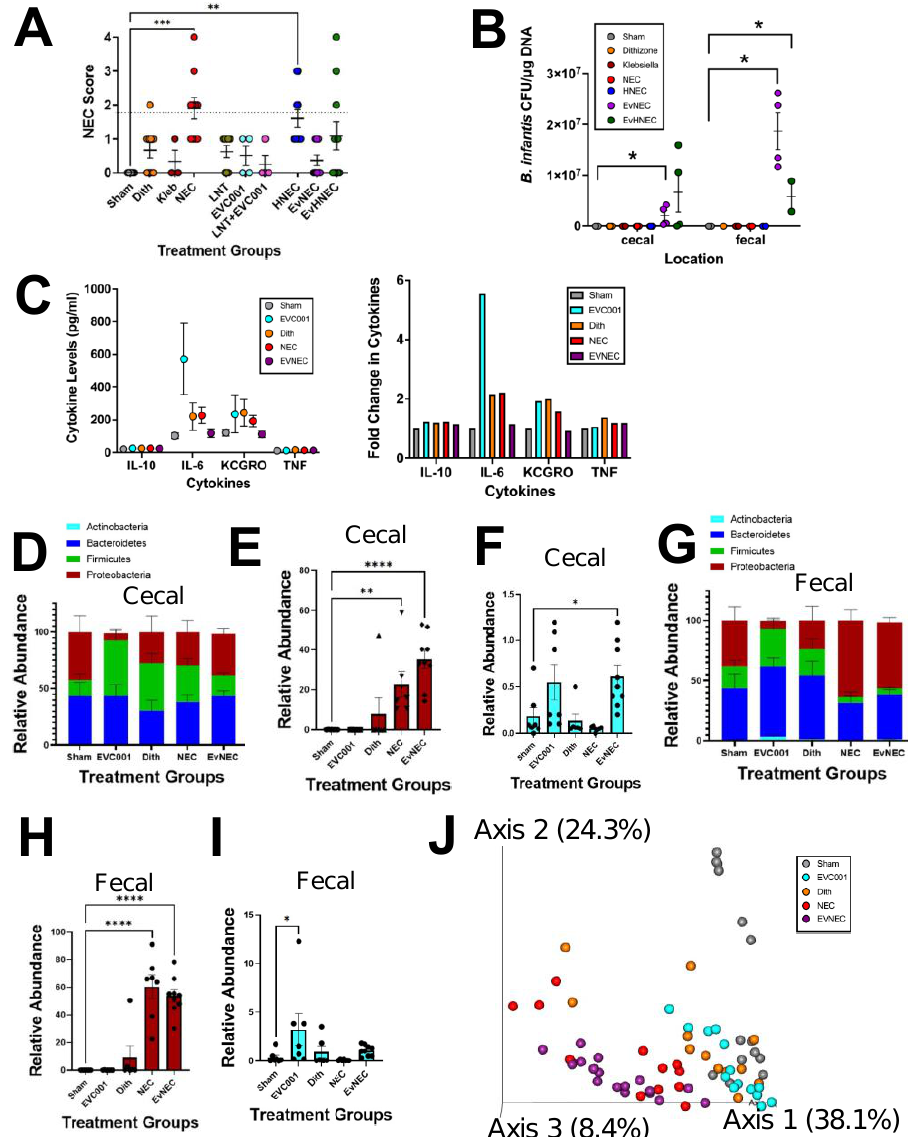
Figure 3. EVC001 decreases experimental NEC injury scores in the Paneth cell disruption with bacterial dysbiosis model. ( A ) NEC injury scores for control mice, NEC mice, and NEC mice receiving LNT (HNEC), without LNT, but with EVC001 (EvNEC) or with LNT and EVC001 (EvHNEC) ( n ≥ 3 mice per group). ( B ) Quantitative PCR probing for B. infantis within the cecal and fecal microbiome ( n ≥ 3 mice per group). ( C ) Serum cytokine levels for IL-10, IL-6, KC-GRO, and TNF and the representative fold changes. ( D ) Phylum level relative abundances for the cecal microbiome ( n ≥ 6 mice per group). ( E ) Enterobacteriaceae family level relative abundances for the cecal microbiome ( n ≥ 6 mice per group). ( F ) Bifidobacteriaceae family level relative abundances for the cecal microbiome (n ≥ 6 mice per group). ( G ) Phylum level relative abundances for the fecal microbiome (colon contents) ( n ≥ 6 mice per group). ( H ) Enterobacteriaceae family level relative abundances for the fecal microbiome ( n ≥ 6 mice per group). ( I ) Bifidobacteriaceae family level relative abundances for the fecal microbiome ( n ≥ 6 mice per group) . ( J ) Weighted UniFrac principal coordinate analysis plot including cecal and fecal samples within each group ( n ≥ 6 mice per group) . For all p values, * ≤ 0.05, ** ≤ 0.01, *** ≤ 0.001, and **** ≤ 0.0001.